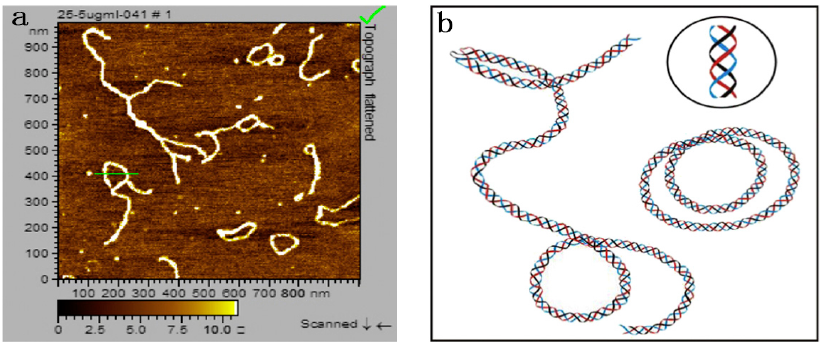
Figure 2. Atomic Force Microscope (AFM) image ( a ) and schematic representation of the lentinan solution at 25 °C ( b ). Adapted from [5], with permission from the American Chemical Society, Copyright 2008.